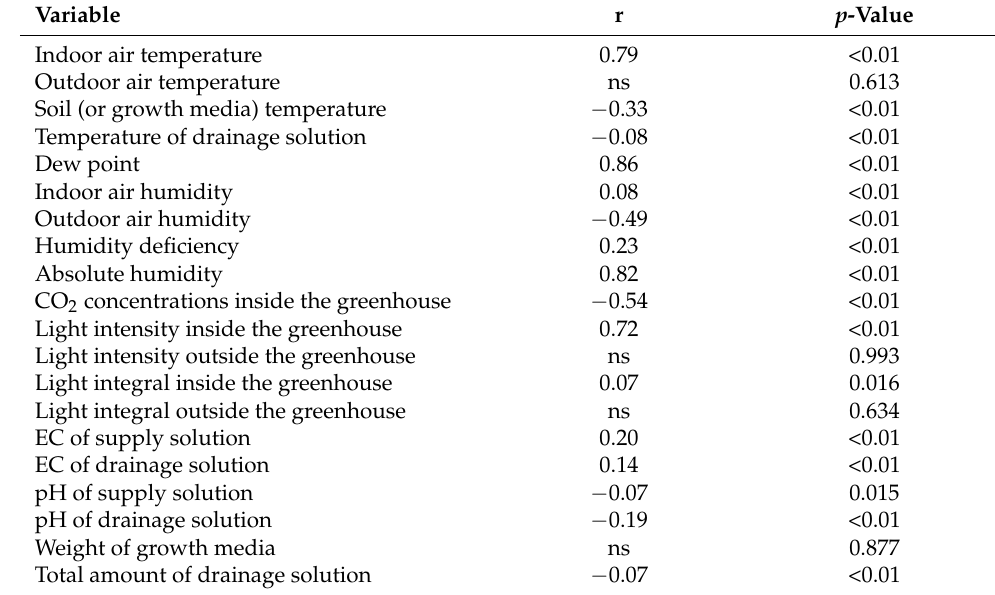
Table 4. Correlations of leaf temperature with other environmental variables under monitoring.